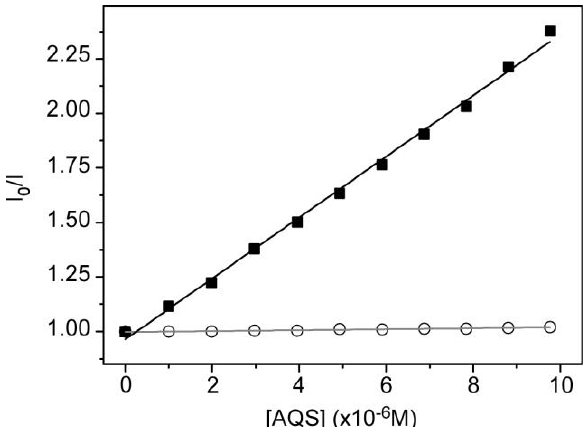
Figure 4. Stern-Volmer plots for quenching of HTMA-PFP (1.5 µM) by AQS in LUVs of DMPC (solid squares) and in LUVs of DMPG (circles). Measurements were performed at 40